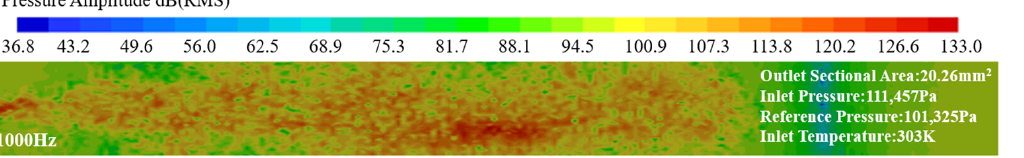
Figure 16. Cloud map of the 1000 Hz near-field sound pressure levels of the equal-diameter nozzle.